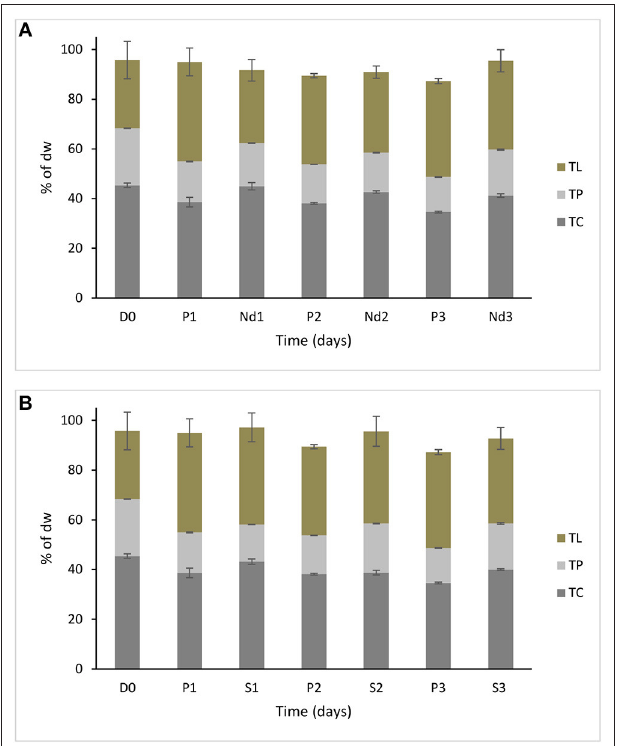
FIGURE 2 | Biochemical composition of S. minutum over time (three days) (A) in nutrient deprivation stress and B) 5% salt stress. Nutrient deprivation stress (Nd1, Nd2, and Nd3) was created by using tap water. Prolonged growth in original wastewater (P1, P2, and P3) algae were kept in municipal wastewater were previously have been grown for 6 days. Treatments of 5% salt stress were represented in S1, S2, and S3.D0 was grown for six days in municipal wastewater before treatment and it represents the start of the experiment. Total lipid (TL), total protein (TP), and total carbohydrate (TC) concentrations are reported as % of biomass dry weight. Bars represent the mean ± SE of five replicates for TL and three replicates for TP and TC.